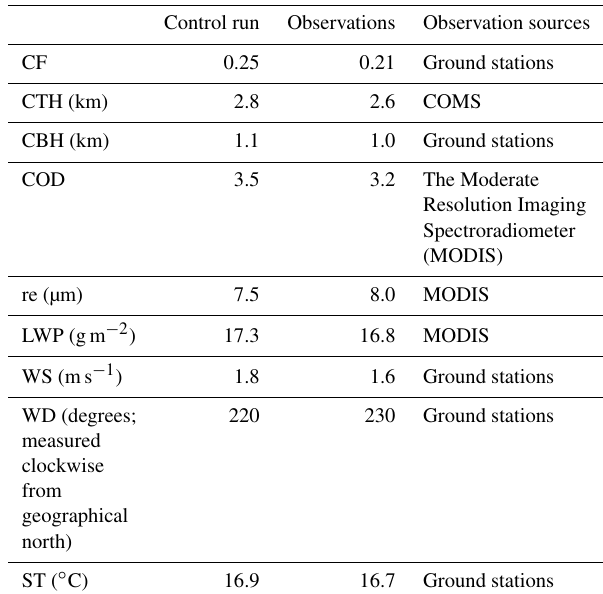
Table 3. The simulated and observed values of cloud and environ- mental variables and the observation sources that have been used to obtain the observed values. At each observation time (simulation time step), cloud fraction (CF) is averaged (obtained) over ground stations (grid points) in the domain as shown in Fig. 1b, and the averaged (obtained) CF is averaged over the simulation period with clouds to calculate the presented and observed (simulated) CF val- ues. To obtain the presented values of cloud-top height (CTH), cloud-bottom height (CBH), cloud optical depth (COD), droplet ef- fective radius (re) and liquid water path (LWP), the observed values at observation spatial points (the simulated values in grid columns for CTH, CBH and LWP and at grid points for COD and re) in the domain are averaged over areas with nonzero values at each observation time (simulation time step) and then over the simula- tion period with nonzero values. To obtain the presented and sim- ulated values of the surface wind speed (WS), the surface wind di- rection (WD) and the surface air temperature (ST), the simulated values are averaged over grid points, which correspond to the at- mosphere immediately above the surface, and the whole simulation period. To obtain the presented and observed values of those surface variables, the observed values are averaged over ground stations and the whole simulation period.